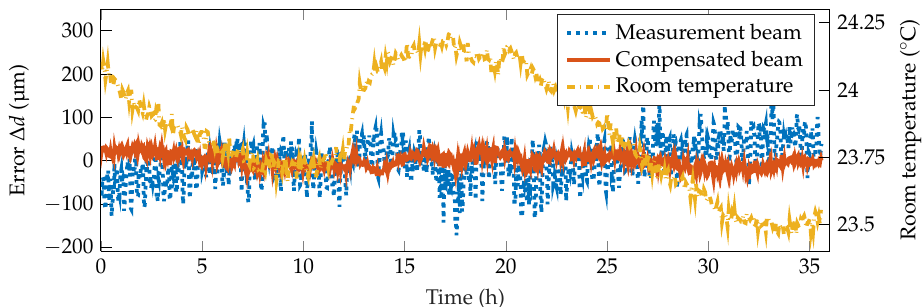
Figure 4. Measurement showing the compensation of drift effects. The measurement beam shows a stronger deviation than the compensated beam. A slight correlation of the measurement beam with the room temperature is